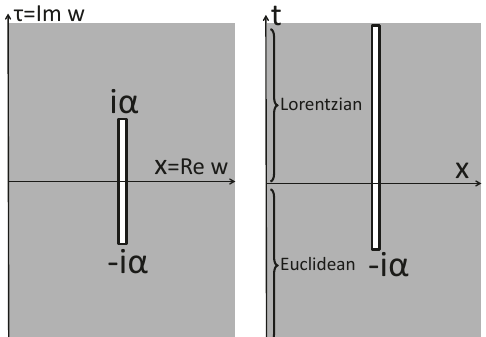
Figure 6 . The geometries which realize the splitting local quenches. The left (cid:12)gure describes the space on which we perform the Euclidean path-integral. This is mapped into an upper half plane by the map (4.1). The right picture describes the path-integral realization of the time evolution after the split process happened at t = 0, where the Euclidean path-integral for (cid:28) < 0 creates the state just after the splitting